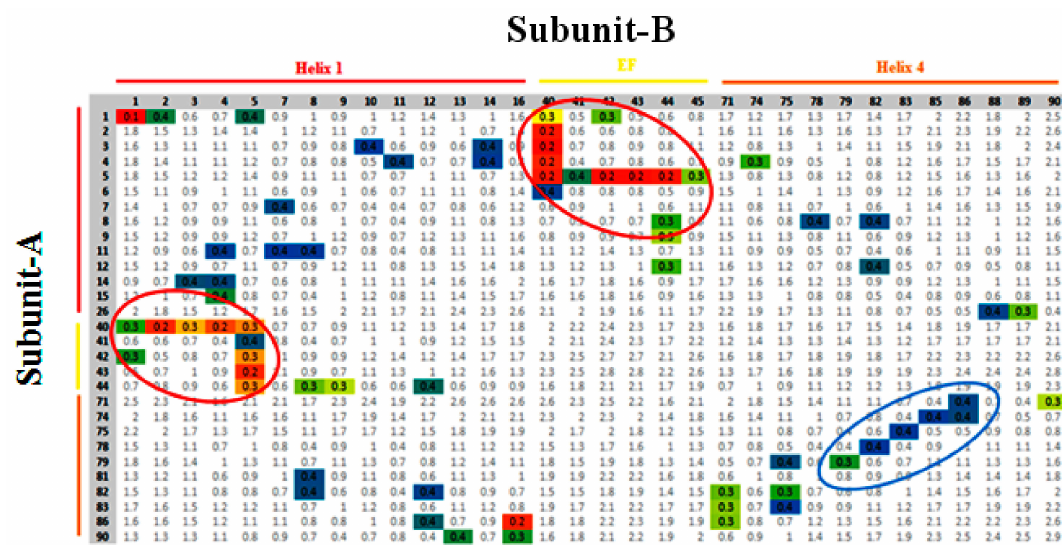
Figure 6. Contact analysis between adjacent domains of subunit A and B in the S100A1 protein during the simulation. The residues of subunit A are detailed in rows, while the subunit B residues are listed in columns. The pattern of contacts between the residues of H1, EF site, and H4, are colored in red, orange, and yellow bars, respectively. The colored pixels represent residues that are at a distance of less than 0.4 nm. The color code of separation distance, shown as mean distance, is blue, which represents a mean distance of more than 0.35 nm. Green represents a mean separation of less than 0.35 nm and more than 0.3 nm. Yellow represents a mean distance of less than 0.3 nm. Red and orange symbolize an average distance of 0.1 nm and 0.2 nm, respectively. The analysis was performed over the time frames of the largest clusters of unlocked and locked states. Red eclipse denotes all significant contacts made by the H1 and EF site of each subunit, whereas the blue eclipse defines the interaction between H4 of each